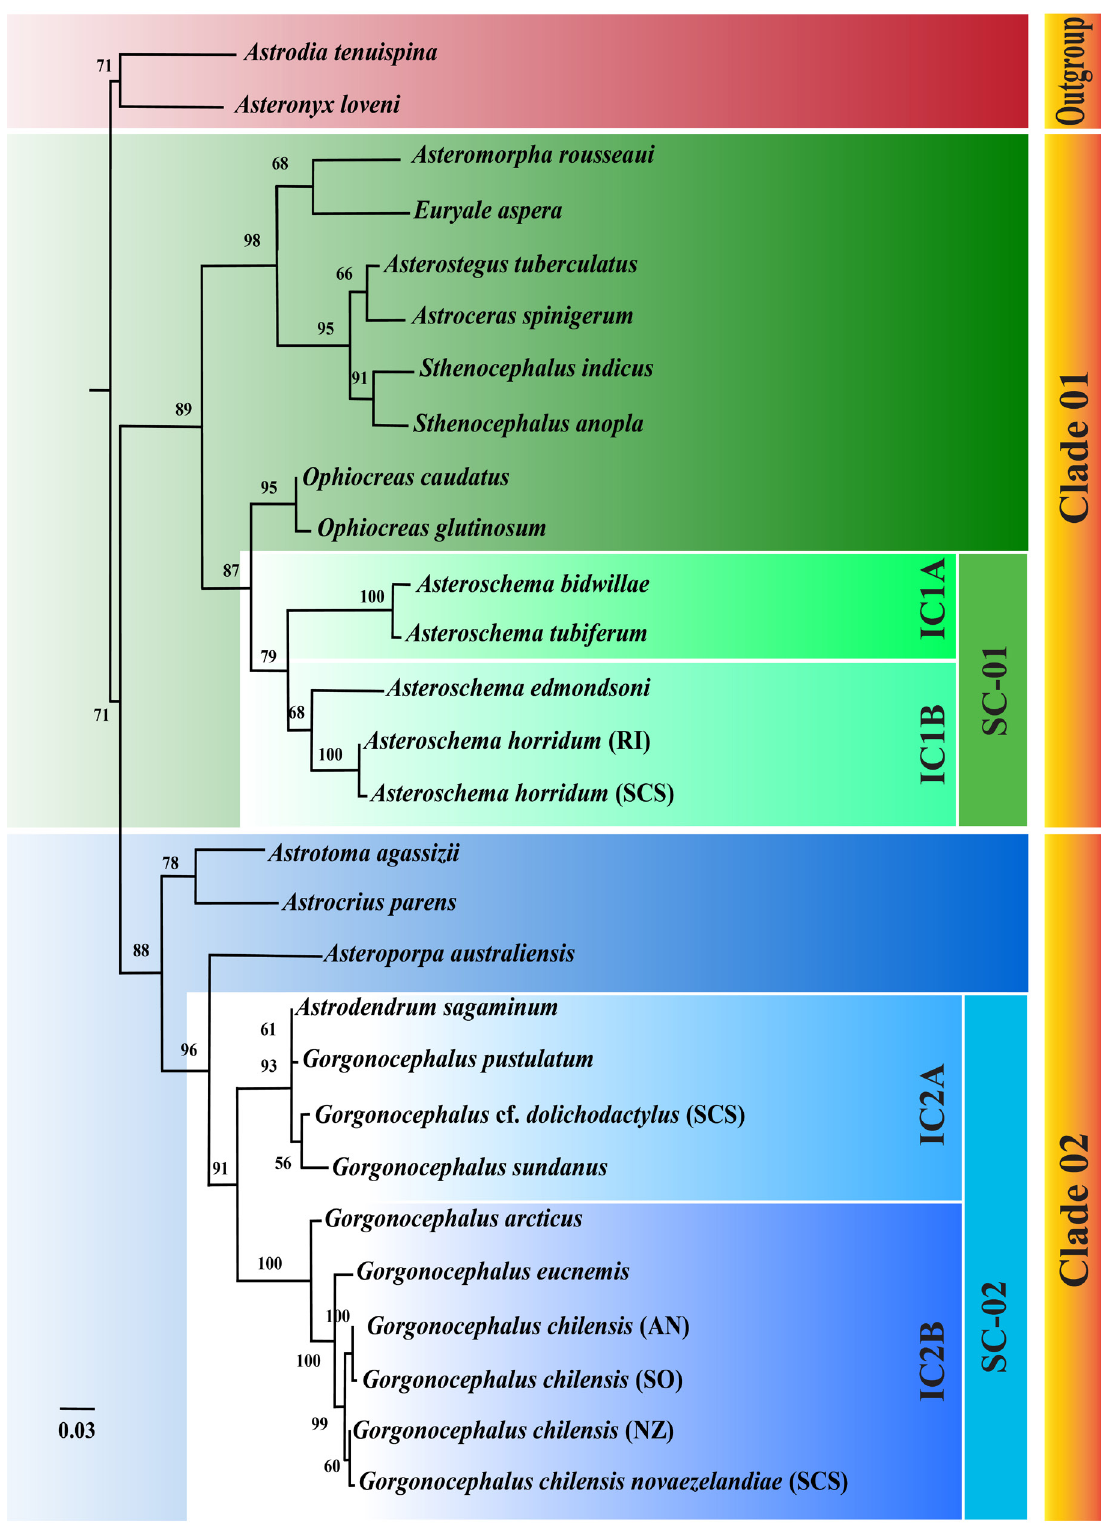
Fig. 44. Families Euryalidae Gray, 1840 and Gorgonocephalidae Ljungman, 1867, Maximum likelihood (ML) tree based on partial COI sequences (bootstrap support values were generated with rapid bootstrapping algorithm for 1000 replicates). Abbreviations: AN = Antarctica; IC = Inter-Clade; NZ = New Zealand; RI = Reunion Island; SC = Sub-Clade; SCS = South China Sea; SO = Sothern